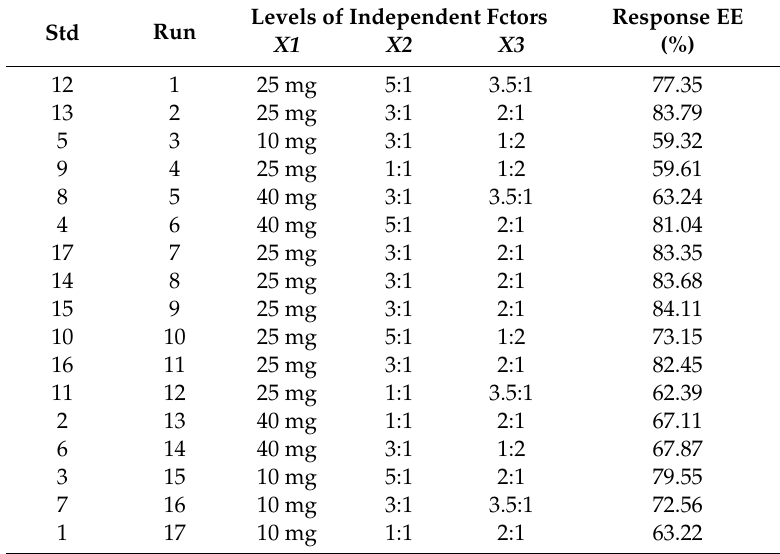
Table 3. The matrix of Box-Behnken design and the responding experimental results.